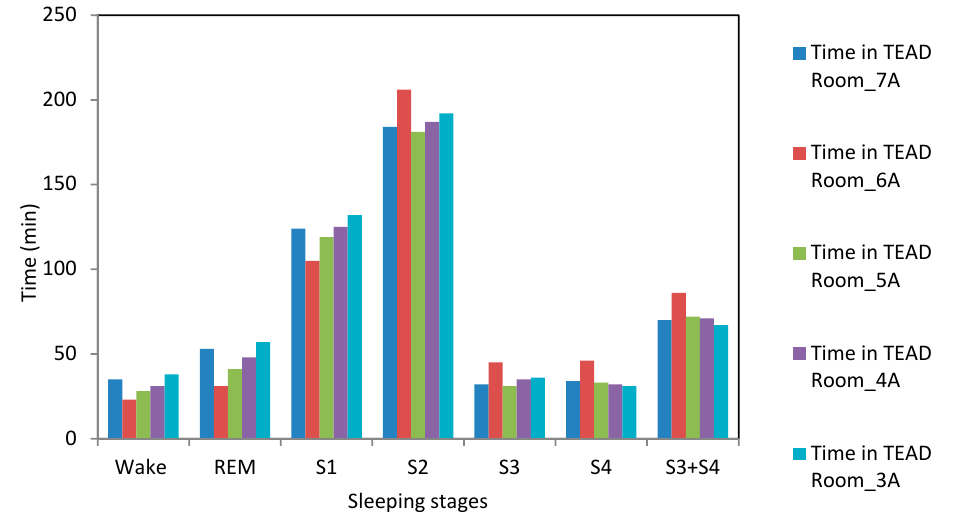
Figure 14. Variation in sleeping stage with varying operating powers.